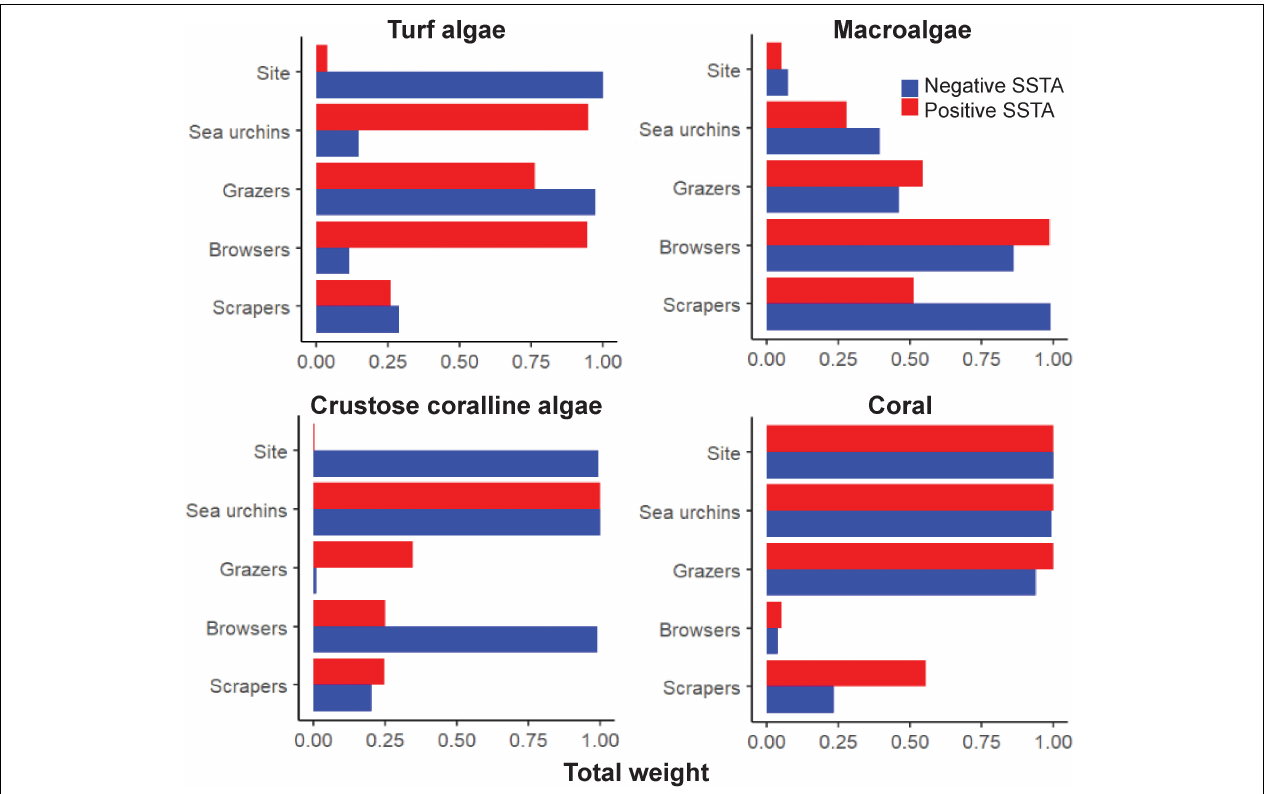
FIGURE 5 | Variable importance scores for each factor in predicting the proportion of benthic cover across warm and cool sea surface temperature anomalies. Importance scores are separated for each benthic type. The higher the number of models the factor was present in, the closer the variable importance score to 1, indicating a higher importance